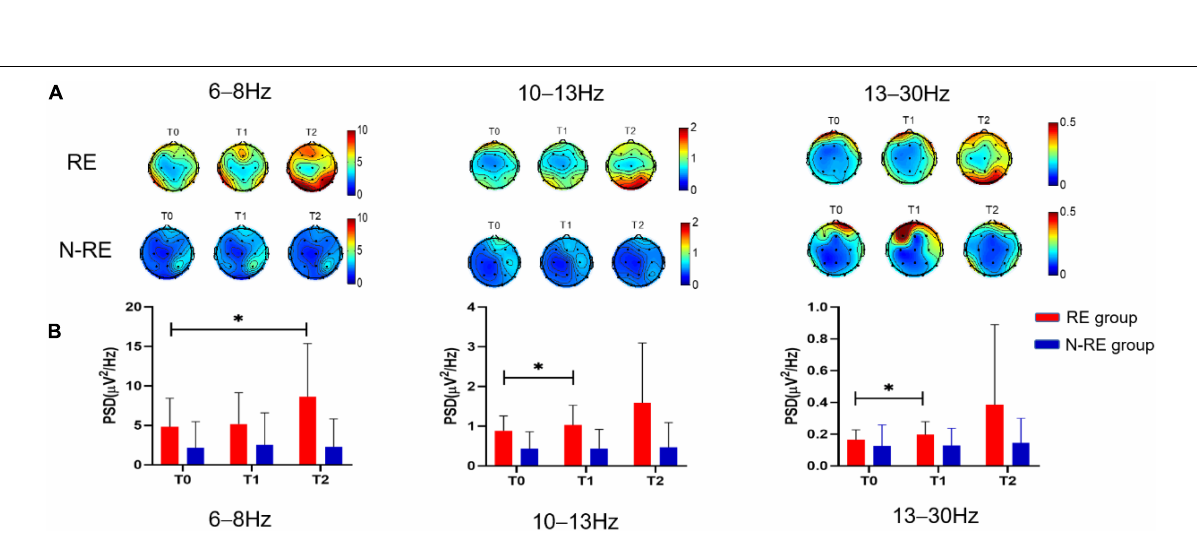
FIGURE 3 | CRS-R total scores (A) and CRS-R subscale scores (B) for all patients before the experiment (T0), after a single session of HD-tDCS (T1) and after treatment for 5 days (T2). CRS-R, Coma Recovery Scale-Revised; * p < 0.05, ** p < 0.01.